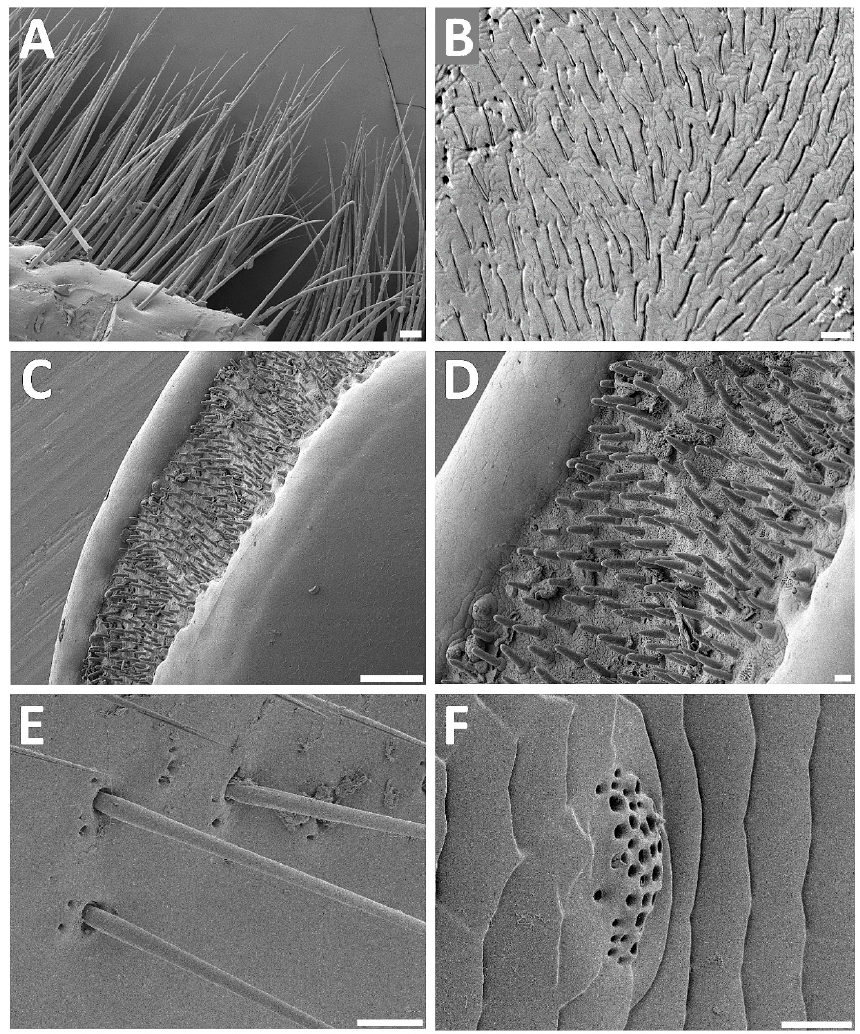
Figure 4. Scanning electron microphotographs of selected parts of T. giganteus body. ( A )—Mechanoreceptor (proprioreceptive) hairs on the anterior edge of prothorax. ( B )—Sensory field on the maxillar palp (digitiform sensilla with sensory parts immersed in elongated cuticular cavities). ( C )—Sensory end of the labial palp. ( D )—Sensory end of the labial palp—detail. ( E )—Abdominal trichoid sensilla surrounded with openings. ( F )—Detail of the abdominal complex secretory opening. Scale bar: 100 μ m ( A , C , E ); 30 μ m ( B ); 10 μ m ( D , F ).